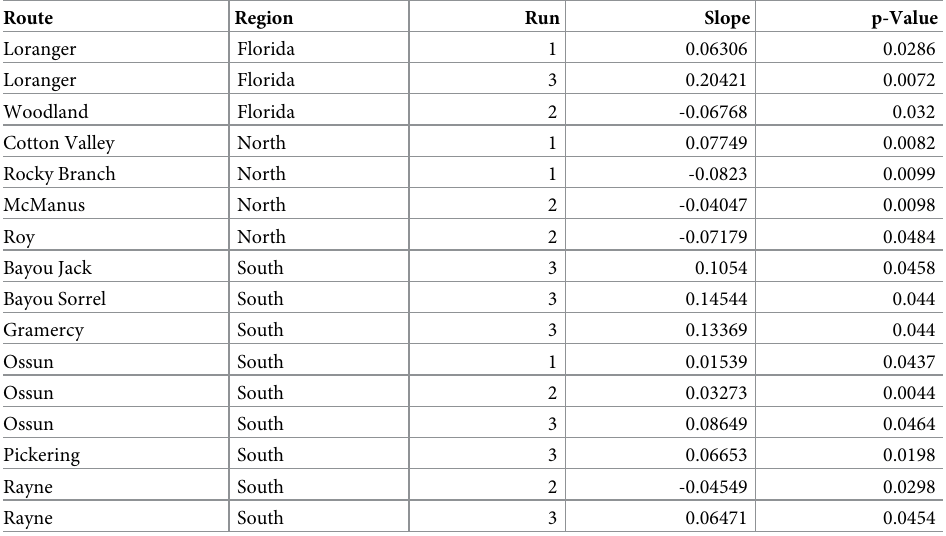
Table 10. Mean route-run species richness linear regression.